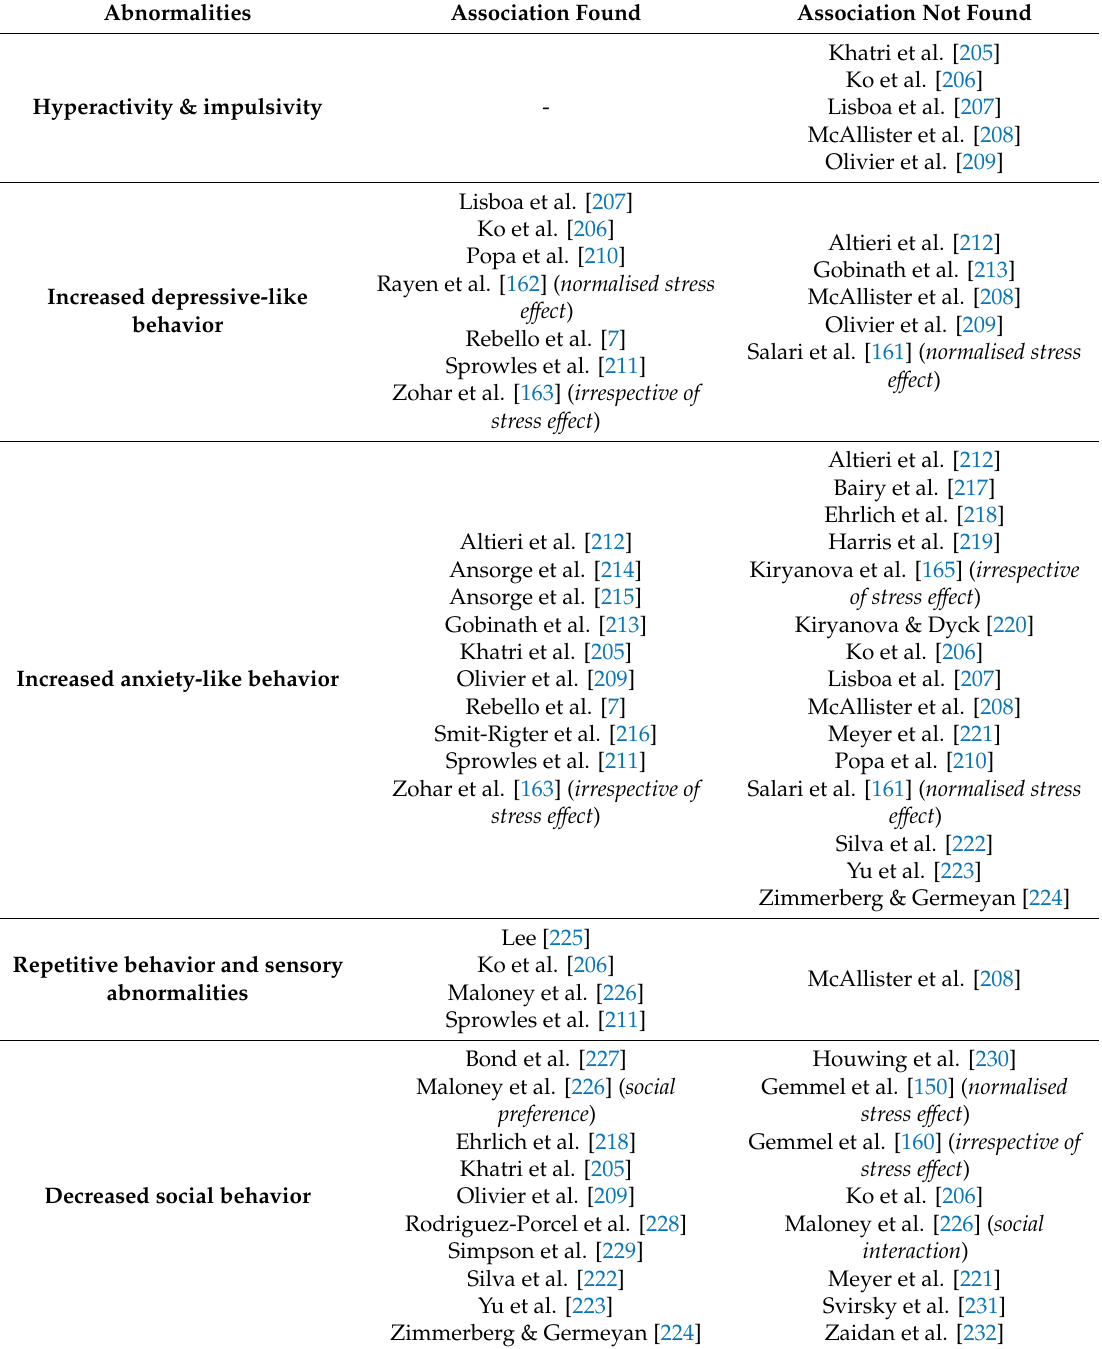
Table 3. Literature overview of associations between perinatal SSRI exposure in rodents and